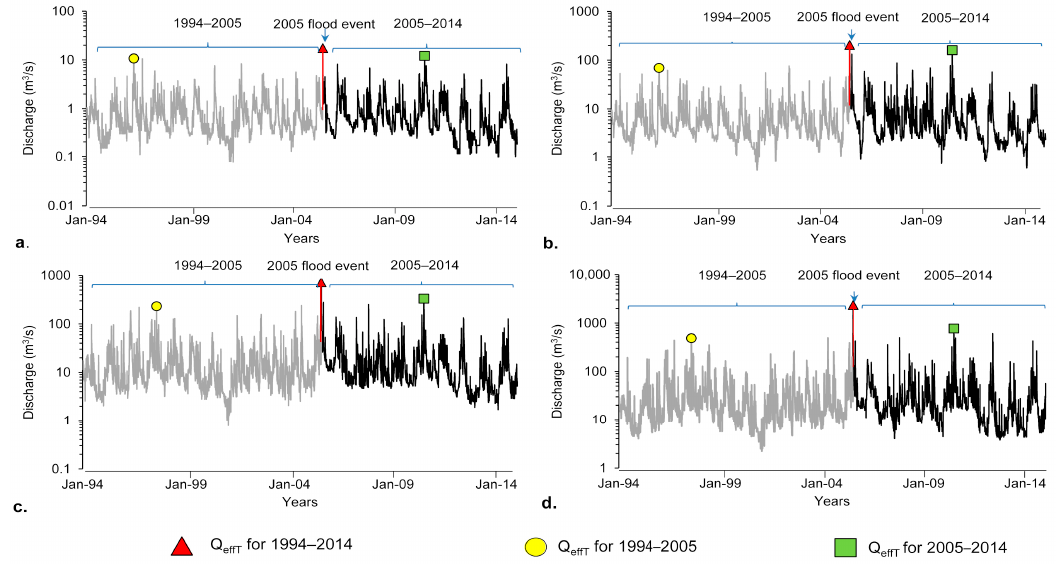
Figure 6. Association of Q effT with peak/maximum values. ( a ) Lunca de Sus; ( b ) Goioasa; ( c ) Târgu Ocna; ( d ) Vrânceni.